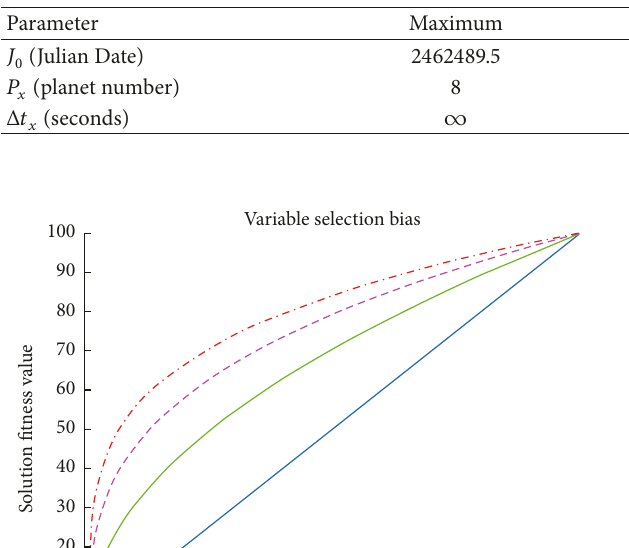
Table 2: Gene specific parameters.